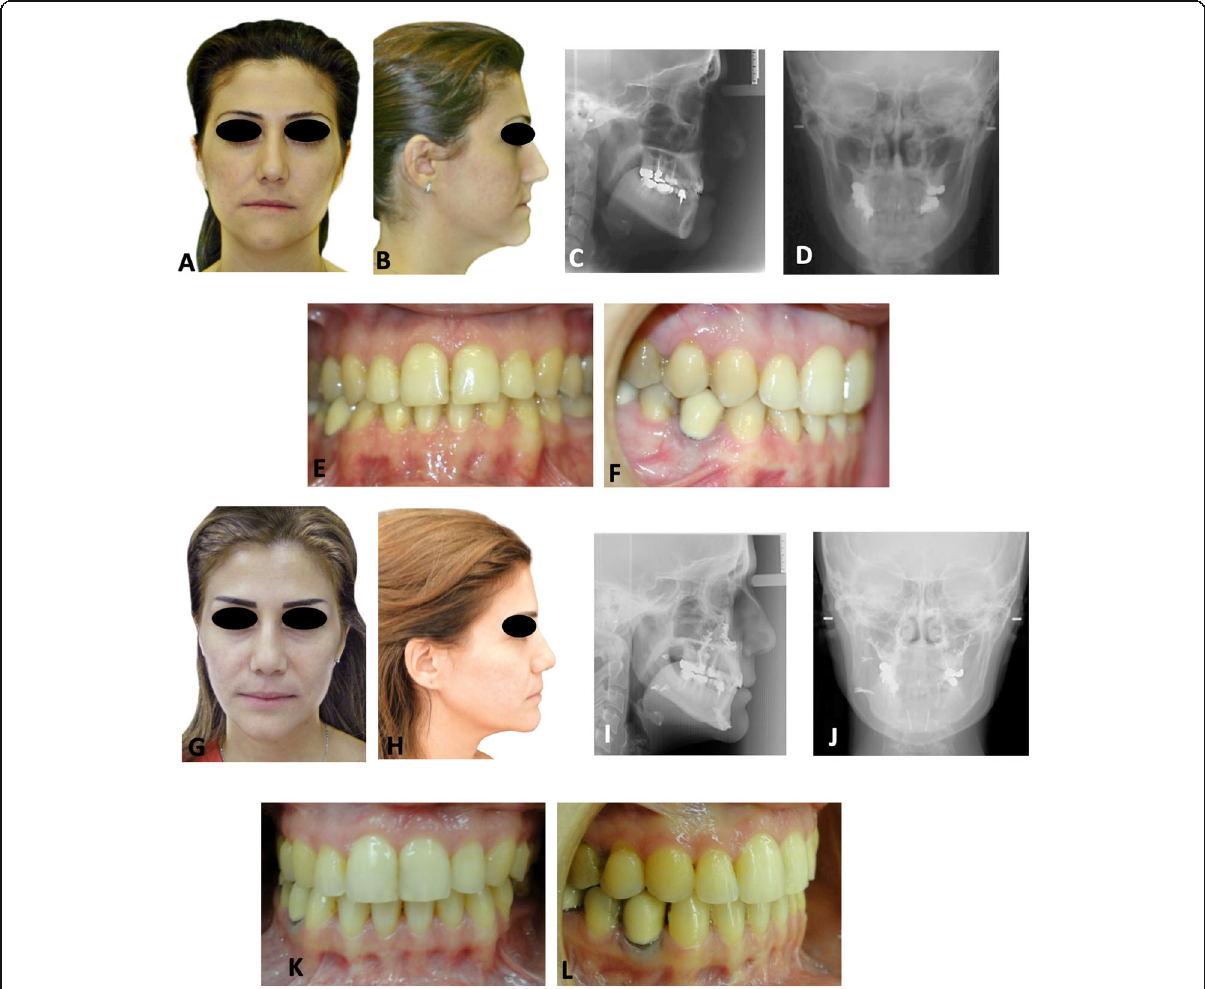
Fig. 3 a , b Pretreatment facial and profile photographs of a 29-year-old female presenting with an orthodontically treated skeletal class III with facial asymmetry. c Lateral radiograph showing the dental camouflage of the class III malocclusion (ANB = − 3.5°) with severely retroclined mandibular incisors. d Posteroanterior radiograph displaying the skeletal asymmetry with an elongated left ramus causing deviation of the mandible to the right. e , f Intra-oral photographs reveal the outcome of the orthodontic camouflage. Note the deviation of the lower dental midline by 2 mm to the right. g – l Corresponding posttreatment facial, radiographic and occlusal records following the maxillary Le Fort I and USSO of the right mandibular ramus associated with genioplasty. Facial asymmetry was resolved ( g , j ), jaw relations rectified (ANB = 1.5°), and incisors in optimal inclinations over corresponding basal bones ( i ) and class I maintained ( k , l ). The midlines of the teeth, chin, and face